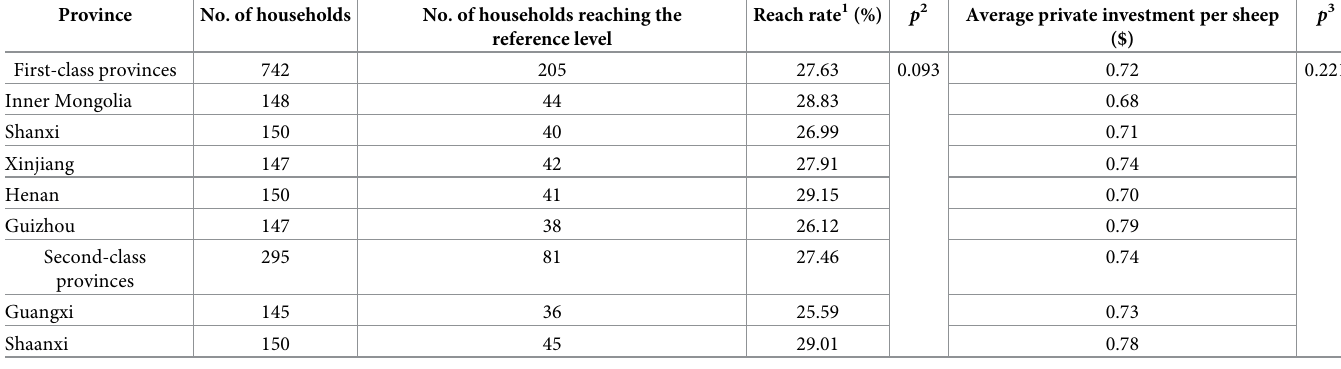
The score of the householders was 70.4 ± 22.7, and the proportion of positive answers of three questions of brucellosis prevention and control behaviors (S1 Part 4) was more than 50%. Approximately 64.1% of the heads of households surveyed did not care about other peo- ple’s attitudes in their daily life, while 79.4% of them were concerned about the health of neigh-